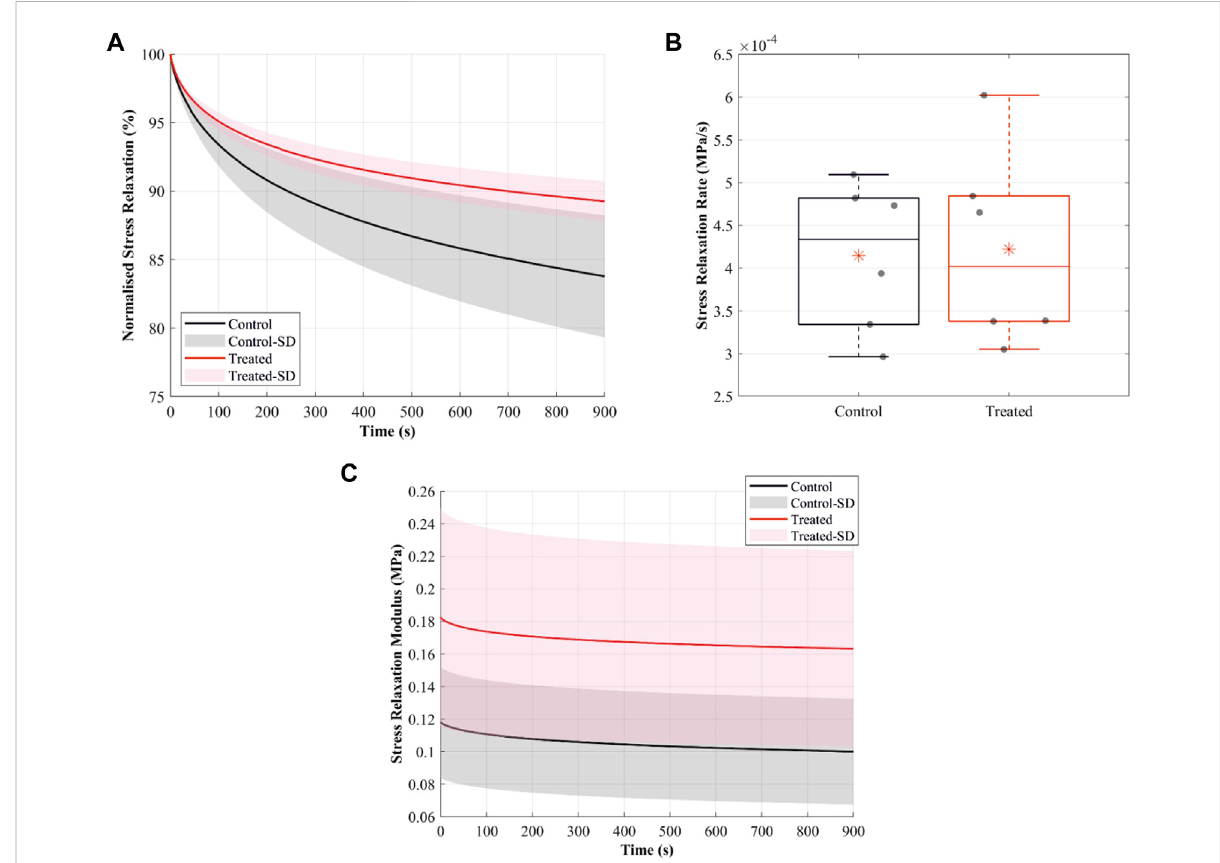
FIGURE 6 Stress-relaxation behaviour of the cranial cruciate ligaments (CCLs) showing (A) normalised stress relaxation-time curves in the control (black lines: mean, grey shade: standard deviation) group, where proteoglycans were not depleted, and in the treated (red lines: mean, light red shade: standarddeviation)group,whereproteoglycansweredepleted. (B) Stressrelaxationrateinthecontrol(blacklines)andthetreated(redlines)groups. The box plot shows individual specimen values (grey dots) and means (red asterisk). The outliers are indicated with a red plus sign. (C) Stress relaxation modulus in the control (black lines: mean, grey shade: standard deviation) and the treated (red lines: mean, light red shade: standard deviation)